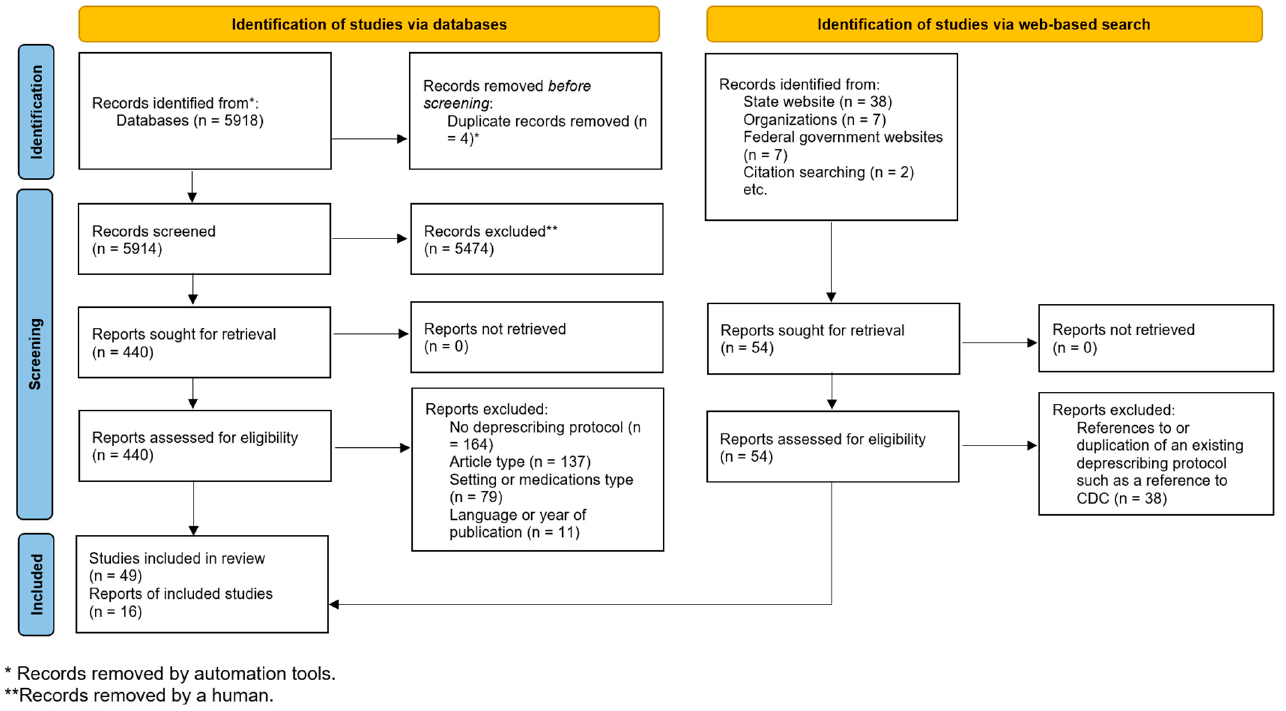
Figure 1. Flow diagram of included